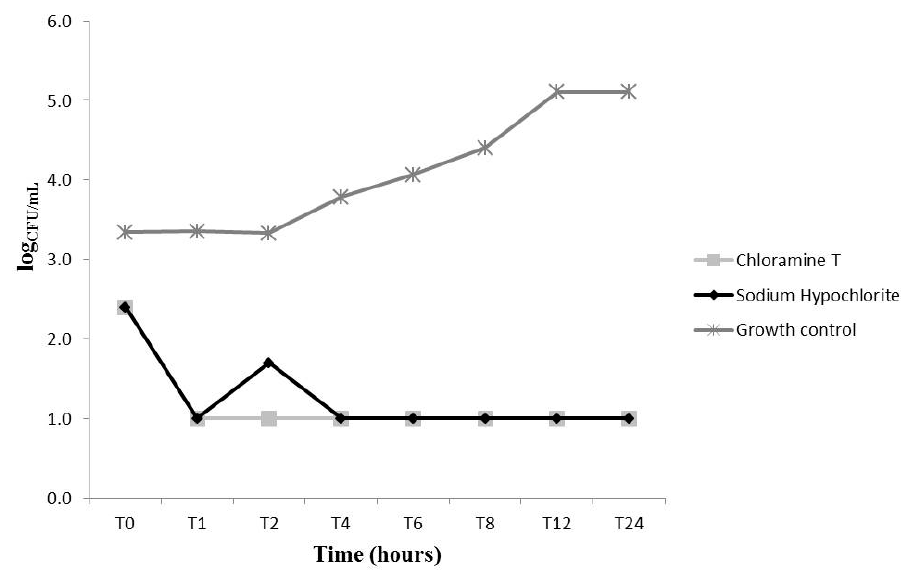
Figure 4. Candida albicans ATCC 60193 fungal growth kinetics upon treatment with chloramine T (11.09 mmol/L) and sodium hypochlorite (35.58 mmol/L) at 4 times their MIC concentrations.